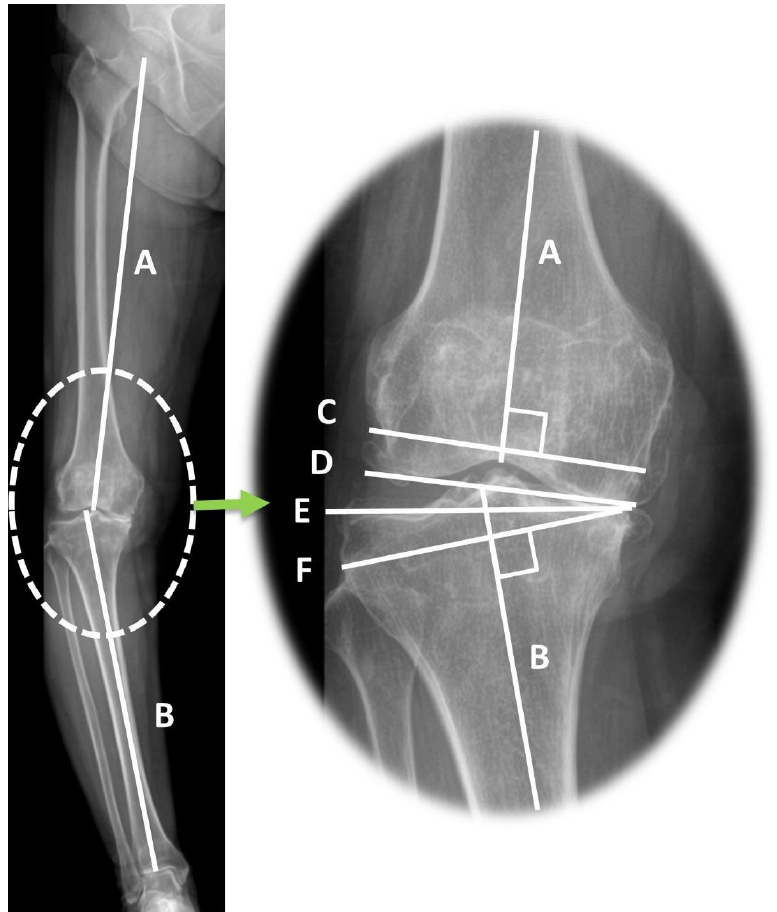
Figure 3. Limb coronal alignments and bone cutting lines demonstrated in standing long leg radiograph. A: Mechanical axis of the femur, B: Mechanical axis of the tibia, C: Distal femur cutting line, D: Distal femoral articular surface, E: Proximal tibial articular surface, F: Proximal tibial cutting line. HKA varus angle: acute angle between A and B; mLDFA: lateral angle between A and D; MPTA: medial angle between B and E; JLCA: angle between D and E. The distal femur (line C) and proximal tibia cutting (line F) were perpendicular to the mechanical axis of the femur (line A) and the mechanical axis of the tibia (line B). The gap between lines C and F (extension gap) shows a trapezoidal gap after bone cutting.